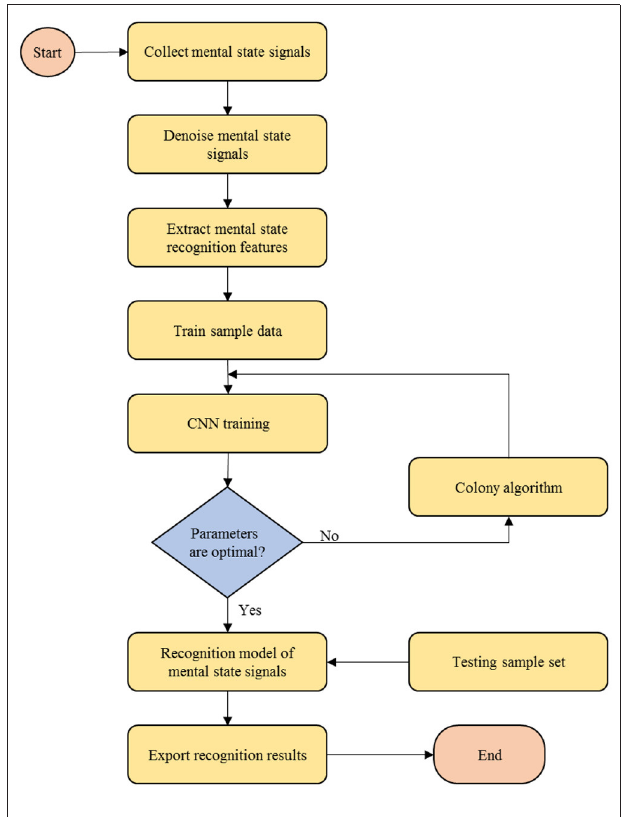
FIGURE 1 | Flowchart of mental state recognition of undergraduates in medical college.